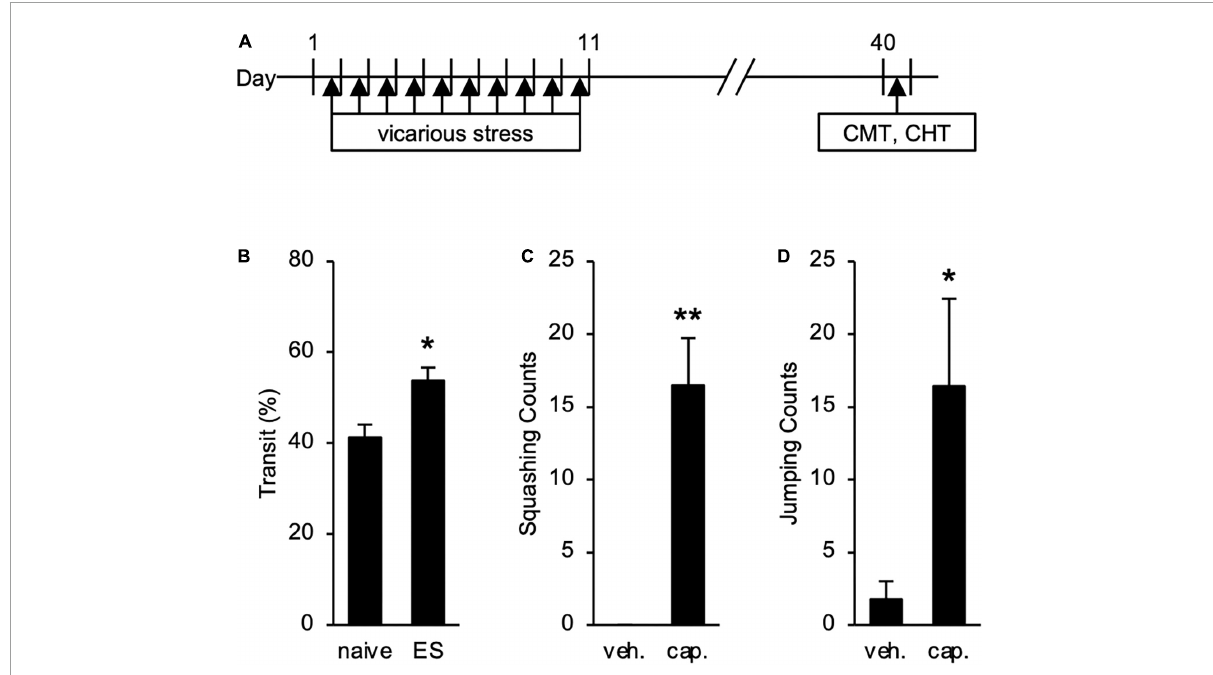
FIGURE5 Long-term Effects of chronic vicarious social defeat stress (cVSDS) on intestinal peristalsis and abdominal hyperalgesia. (A) Experimental design to evaluate long-term effects of cVSDS. CMT: charcoal meal test; CHT: capsaicin-induced hyperalgesia test. (B) Intestinal transit ratio in the charcoal meal test. Data are presented as means ± s.e.m., and analyzed using Student’s t -test. * p < 0.05. naive, n = 6; ES, n = 5. (C,D) Visceral pain-related behavior counts in the capsaicin-induced hyperalgesia test. (C) Squashing; (D) Jumping. veh.: vehicle; cap.: capsaicin. Data are presented as means ± s.e.m., and analyzed using two-way factorial ANOVA, followed by Bonferroni’s post hoc test. * p < 0.05, ** p < 0.01. naive, n = 12; ES, n = 12.